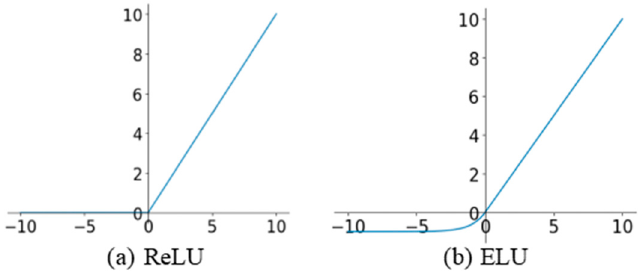
Figure 3. Rectified linear unit (ReLU) and exponential linear unit (ELU) activation functions. ( a ) ReLU; ( b ) ELU.